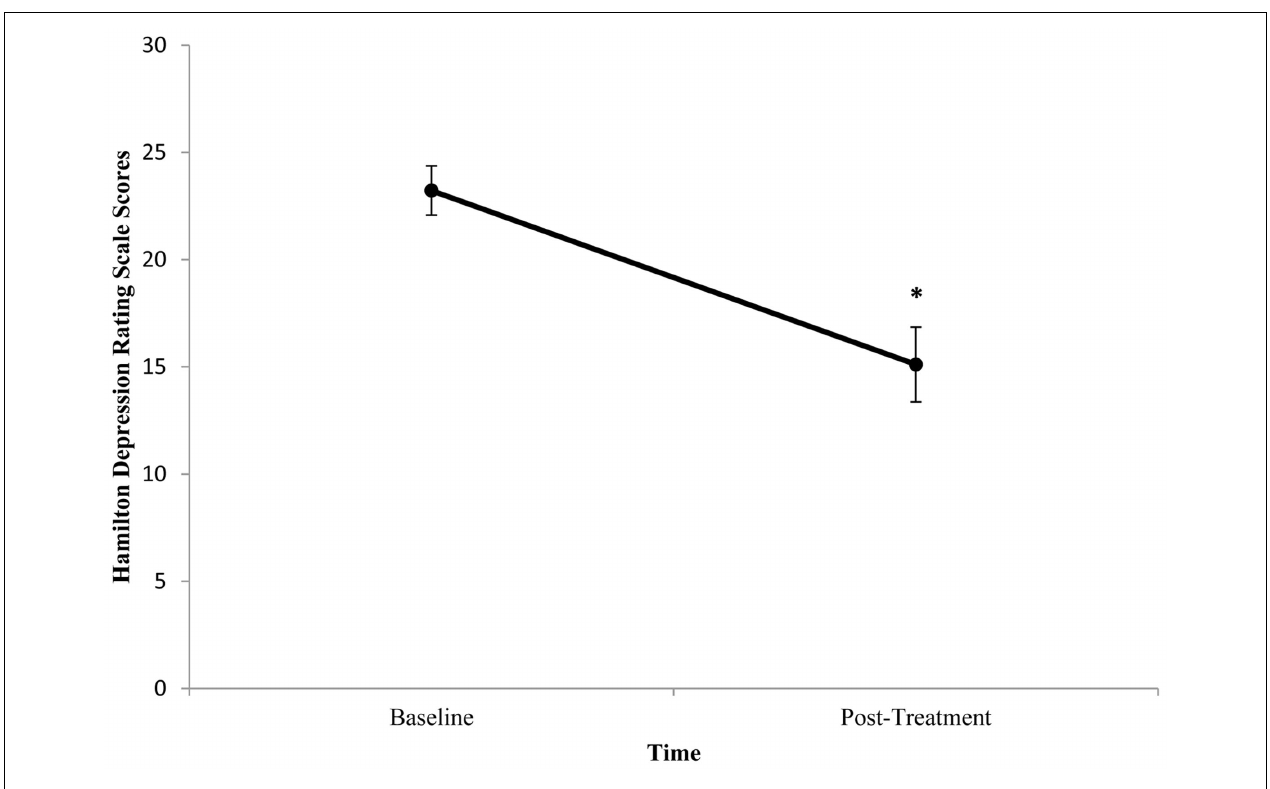
(rTMS). HDRS scores were determined 1week prior to and 1week following rTMS. HDRS scores significantly decreased following rTMS ( p < 0.001). Values are mean ±